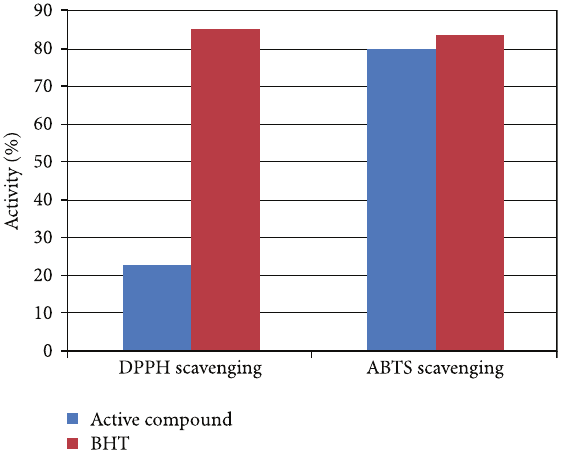
Figure 2: Antioxidant activity of the separated pure compound from ethyl acetate extract (of spring collected alga) by DPPH and ABTS methods at 100 μ